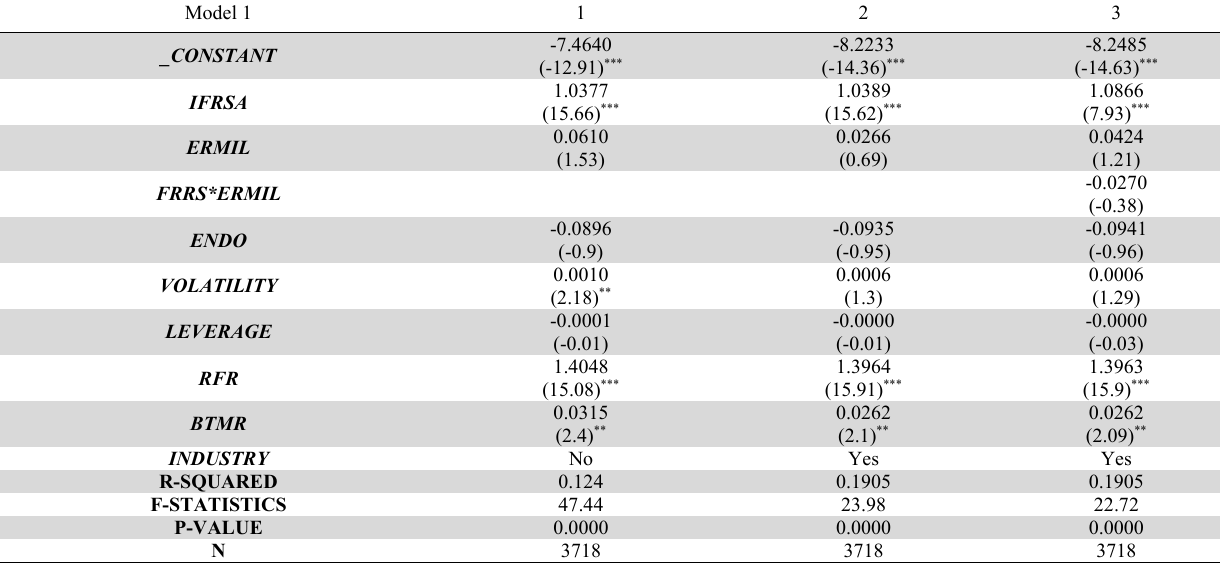
The summary of the regression results using modified Jones